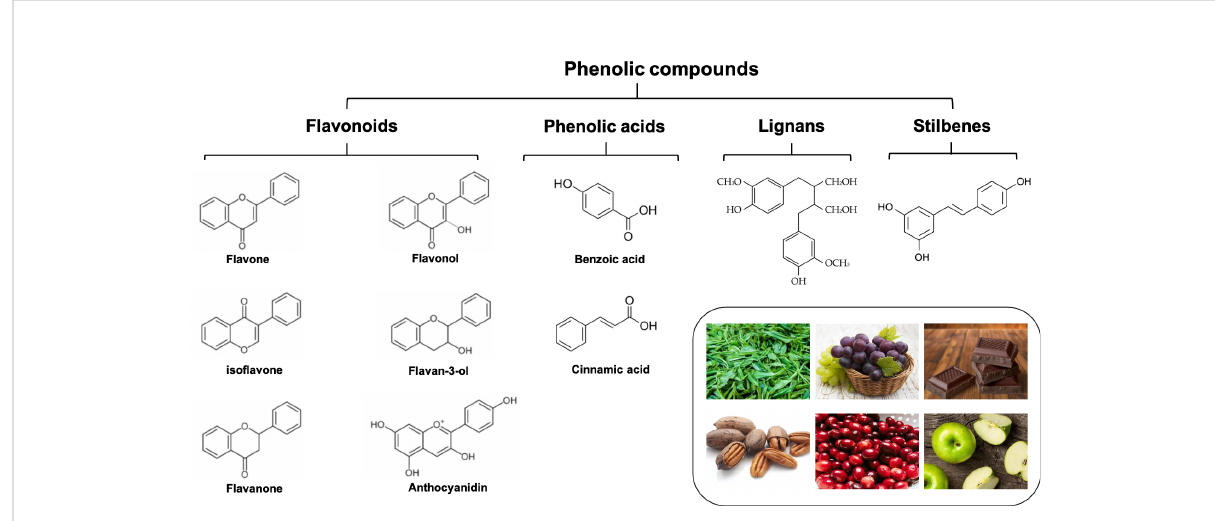
FIGURE 1 The basic classi fi cation of common